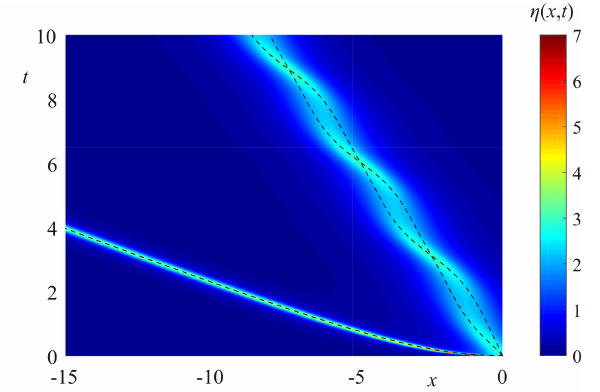
Figure 4. The evolution of the interface is shown for the initial conditions: p 1 = − 0.075 i , p 2 = − 0.6 i , p 3 = − 1.15 i . Black dashed lines correspond to the pole positions at real x